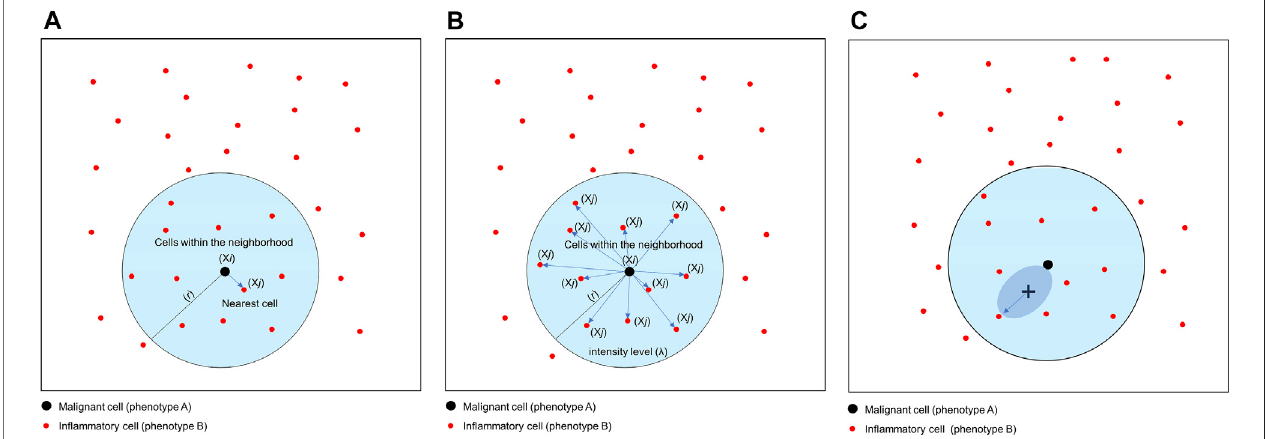
FIGURE8| Graphicsofnearestneighbordistance,K-functionandempty-spaceF-function. (A) Distancematrixshowingtheconceptofnearestneighbordistance, used to determine the probability of encountering a cell of a speci fi c phenotype [X i , in fl ammatory cell (phenotype B)] within a certain radius ( r ) centered on another cell phenotype [X j , malignant cell (cell phenotype A)]. (B) Distance matrix showing the concept of the K-function to determine the intensity level ( λ ) of cells of a certain phenotypewithinacertainradius( r )ofanothercellphenotype. Inthisexample,thefunctioniscalculatingthe λ ofcellphenotype B(X j )fromcellphenotypeA(X i )ina point pattern. (C) Graphic representation of the empty-space F-function, which compares distances from an arbitrary point (x) to the nearest neighbor cell or point. The graphics were generated using R studio software version